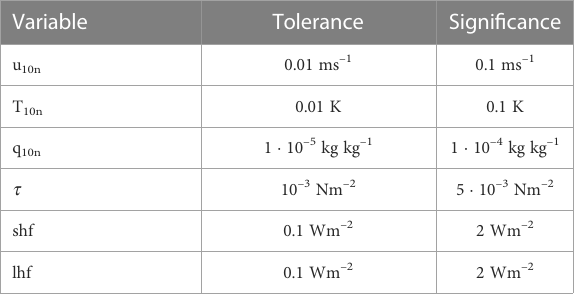
TABLE 2 “ Tolerance ” are the default values used to test for convergence. Variable